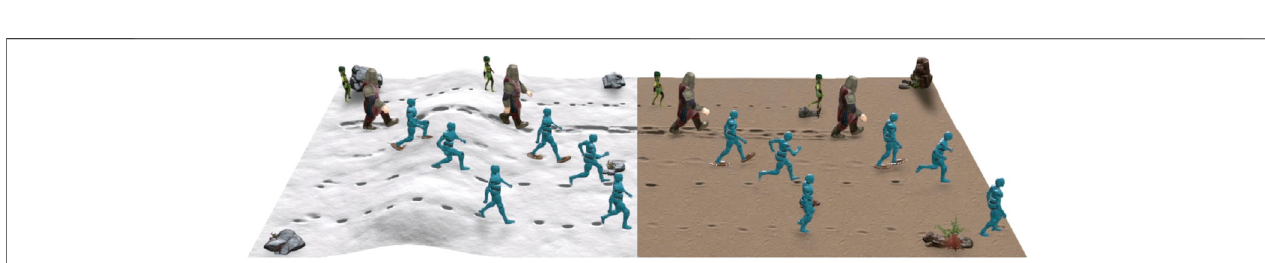
FIGURE 4 | Kinematics-driven characters walking and running on different soft terrains (snow and sand). Our method generates dynamic footprints that take physical parameters (weight, velocity, contact surface) into account, as well as the nature of the terrain. This deformation is coupled with an adaptive locomotion model leading to coherent, real-time coupling between character gait and dynamic terrain